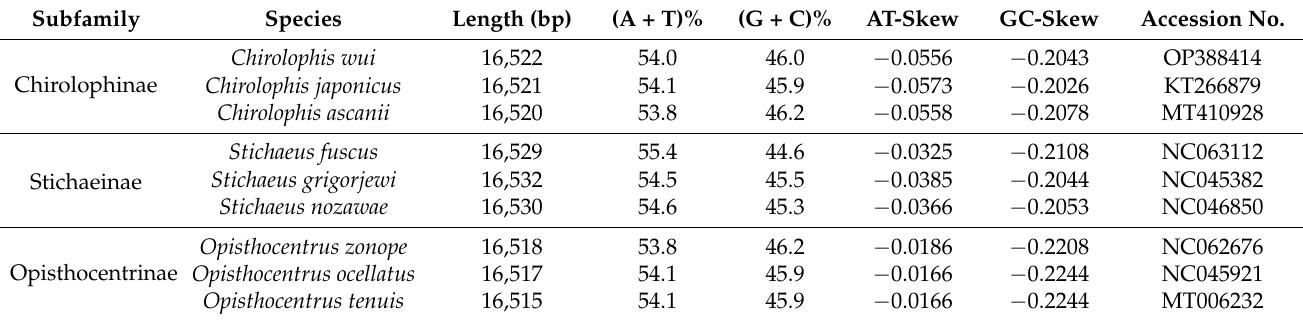
Table 1. The list of mitogenomes used in this